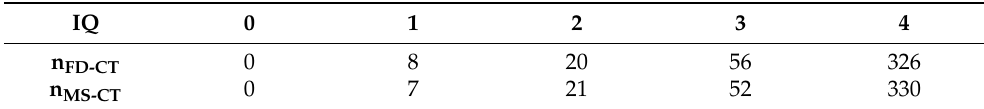
Table 2. Evaluation of image quality (IQ).